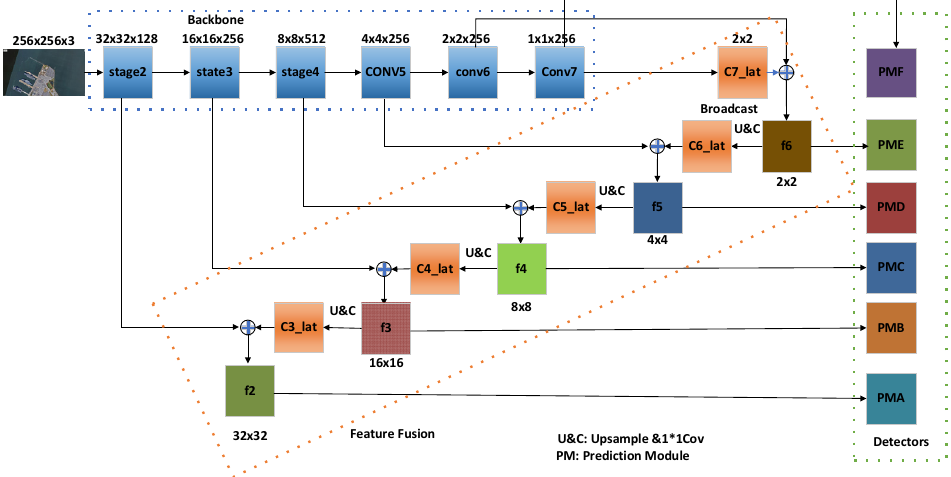
Figure 2. The overall structure of the proposed multi-scale feature detector (MSF-SNET) algorithm framework with six detectors, named (prediction module A) PMA, PMB, PMC, PMD, PME, and PMF. Each component consists of this framework will be described in detail in 3.1.2.